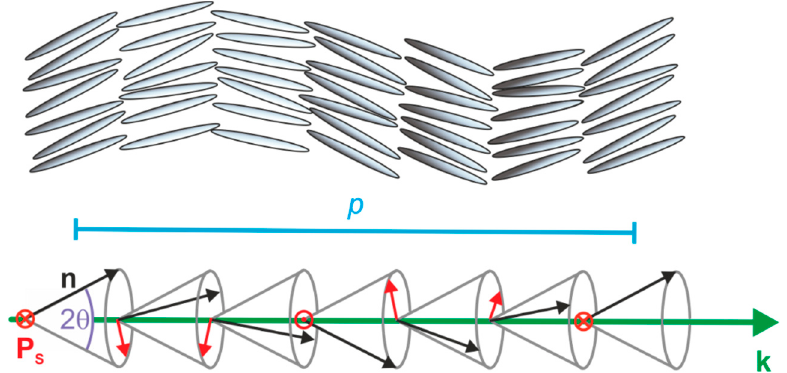
Figure 3. Helical superstructure of a chiral smectic C (SmC*) phase depicted with hard rods (top) and vectors (bottom). The director n (black) and the spontaneous polarization P s (red) are twisted along the direction of the layer normal k (green) from layer to layer with a helical pitch p (blue). The latter is typically in the micron range, and thus, several orders of magnitude larger than the layer spacing d .